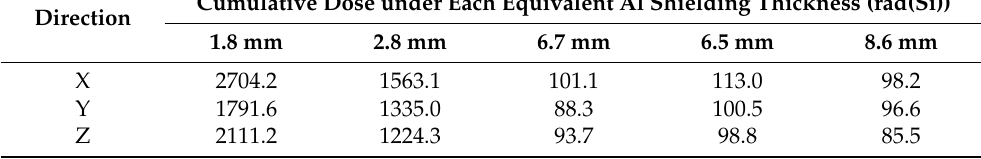
Table 6. The cumulative dose measured under different shielding thicknesses in each